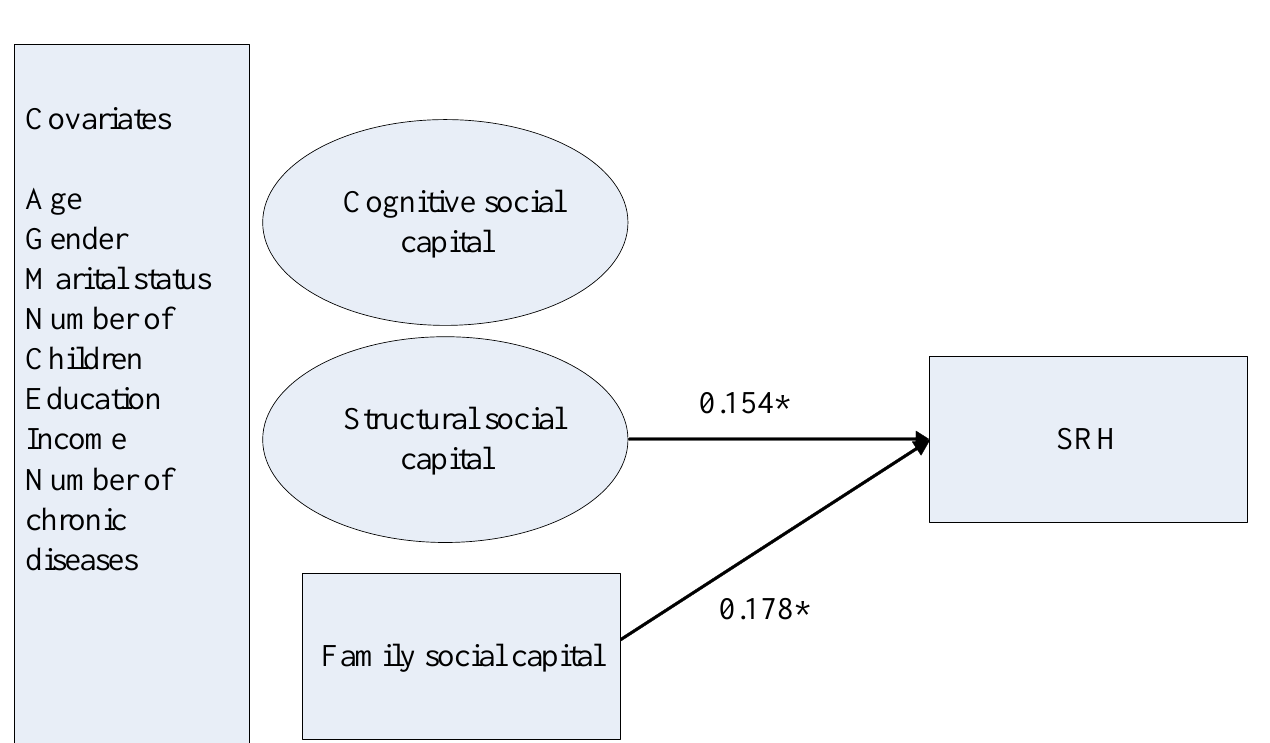
Figure 1. The structural model of family and community social capital, and SRH. Notes: We reported standardized coefficients in this figure. * p < 0.05 (two-tailed); SRH = self-rated health; cognitive and structural dimensions of social capital are